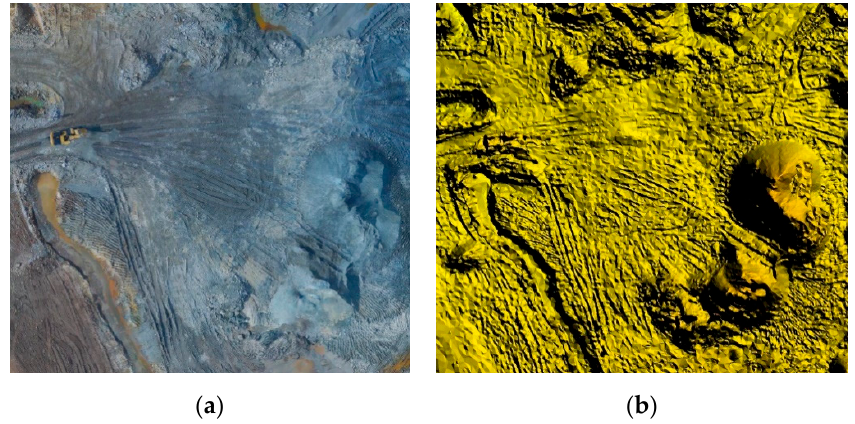
Figure 2. Positive photograph and corresponding DSM of the cutting zone. ( a ) is the positive photograph; ( b ) is the digital surface